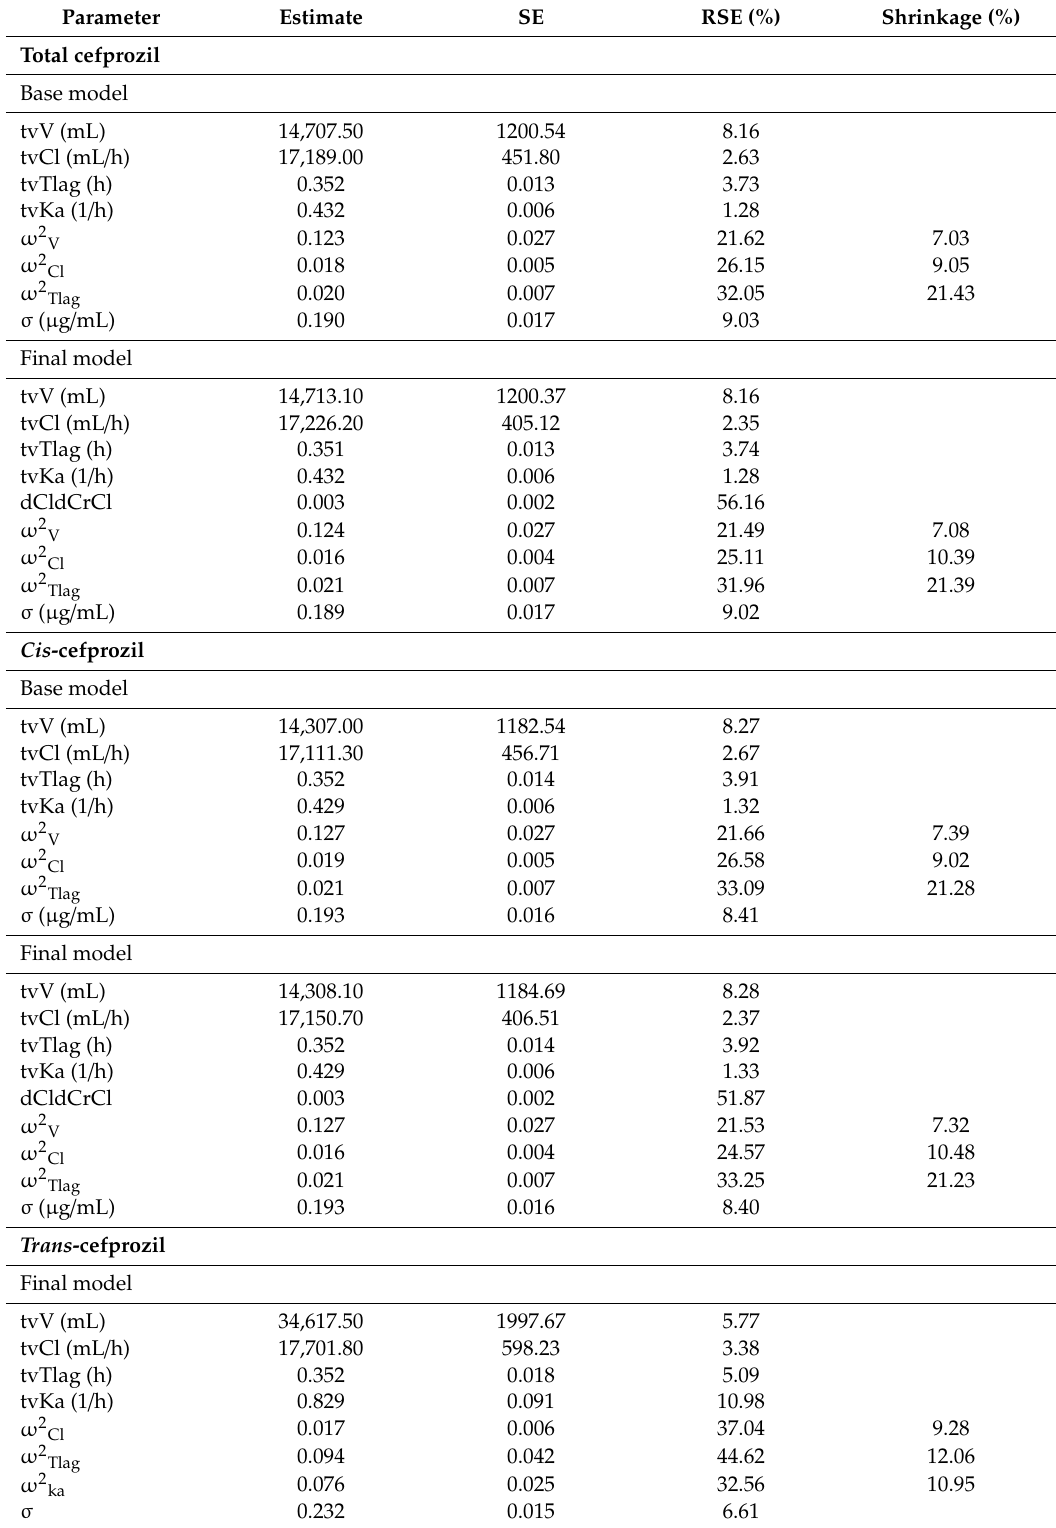
Table 4. Population pharmacokinetic parameters for cefprozil in base and final models.